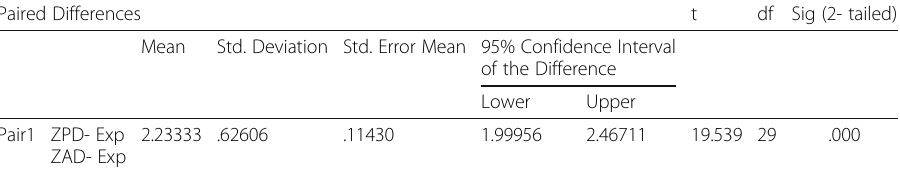
of the Difference Lower Upper